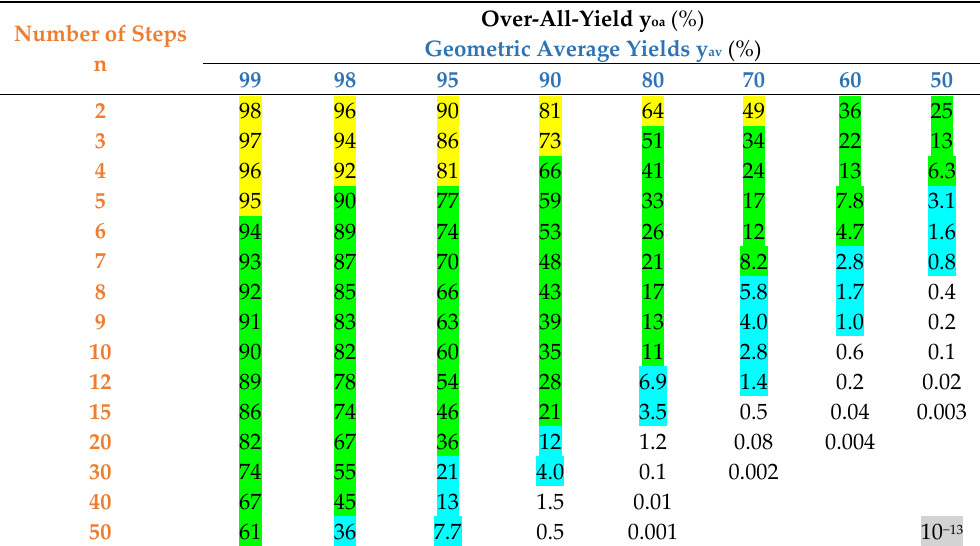
Molecules 2017 , 22 , 349 10 of 32 Molecules 2017 , 22 , 349 10 of 32 Table 4. Overall yields y oa dependent on geometric average yields y av and numbers n of steps of Table 4. Overall yields y oa dependent on geometric average yields y av and numbers n of steps of Table 4. Overall yields y oa dependent on geometric average yields y av and numbers n of steps of Table 4. Overall yields y oa dependent on geometric average yields y av and numbers n of steps of Molecules 2017 , 22 , 349 syntheses. highly profitable short syntheses, usual pharma production, high-chem syntheses. highly profitable short syntheses, usual pharma production, high-chem syntheses. highly profitable short syntheses, syntheses. highly profitable short syntheses, usual pharma production, high-chem Table 4. Overall yields y oa dependent on geometric average yields y av and numbers n of steps of research preparations. syntheses. highly profitable short syntheses, usual pharma production, high-chem research preparations. research preparations. Table 4. Overall yields y oa dependent on geometric average yields y av and numbers n of steps of research preparations. syntheses. highly profitable short syntheses, usual pharma production, high-chem research preparations. Over-All-Yield y oa (%) Number of Steps Geometric Average Yields y av n